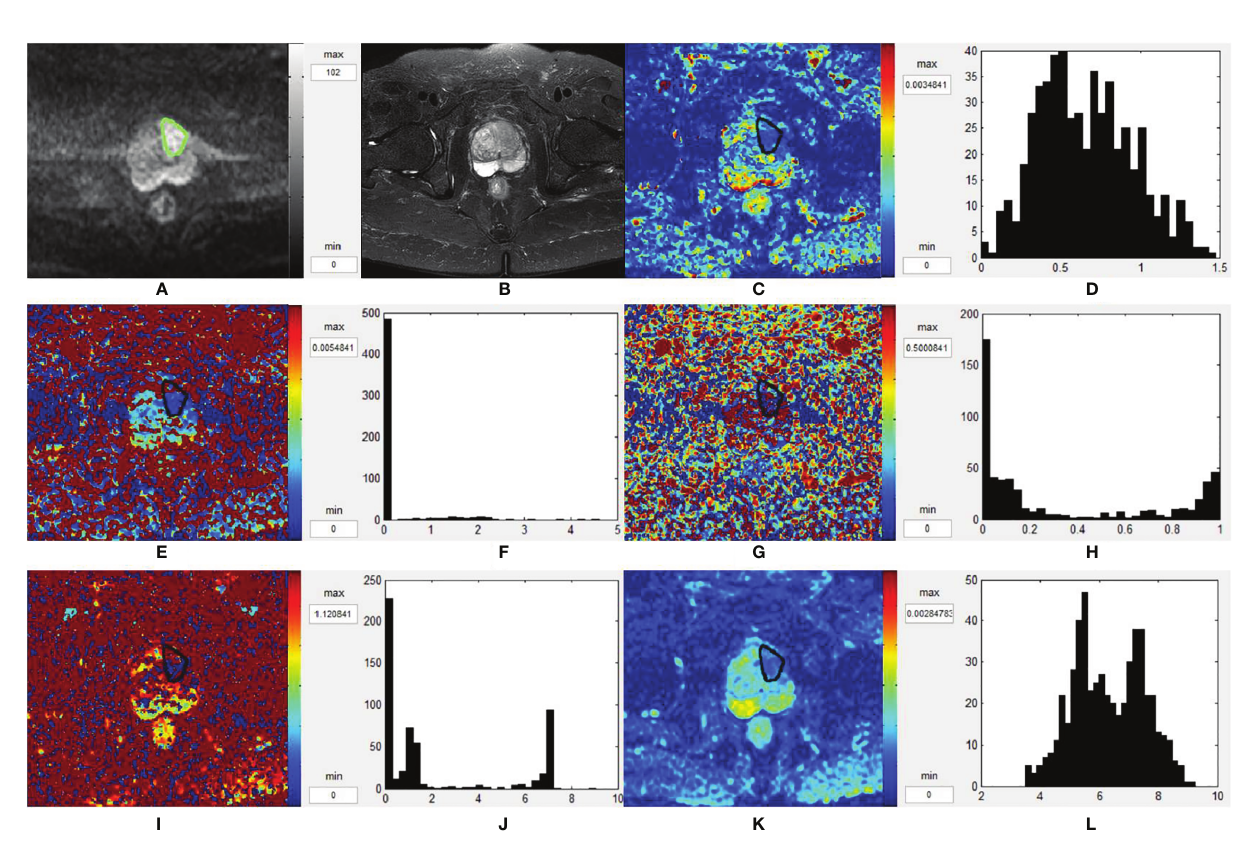
FIGURE 4 | Representative images from a 76-year-old PCa patient with Gleason score of 3 + 4, as outlined on the images. (A – L) Axial DWI ( b = 1,500 s/mm 2 ), axial T2WI, D map, histogram of D , D * map, histogram of D *, f map, histogram of f , K map, histogram of K , ADC map, and histogram of ADC, respectively. PCa, prostate cancer; T2WI, T2-weighted images; DWI, diffusion-weighted images; ADC, apparent diffusion coef fi